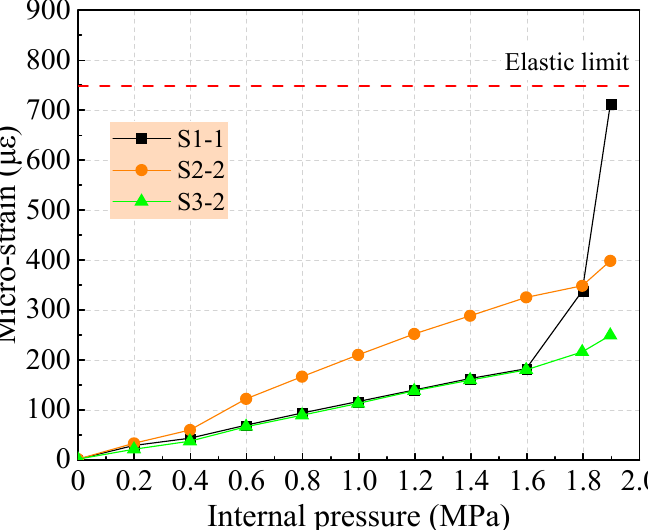
Figure 13. Control strain of prestressed steel wire at each stage. If concrete cracks developed, the pipe shall behave an elastic response to prevent damage or loss of prestressing, which was defined as the elastic limit [7]. This limit